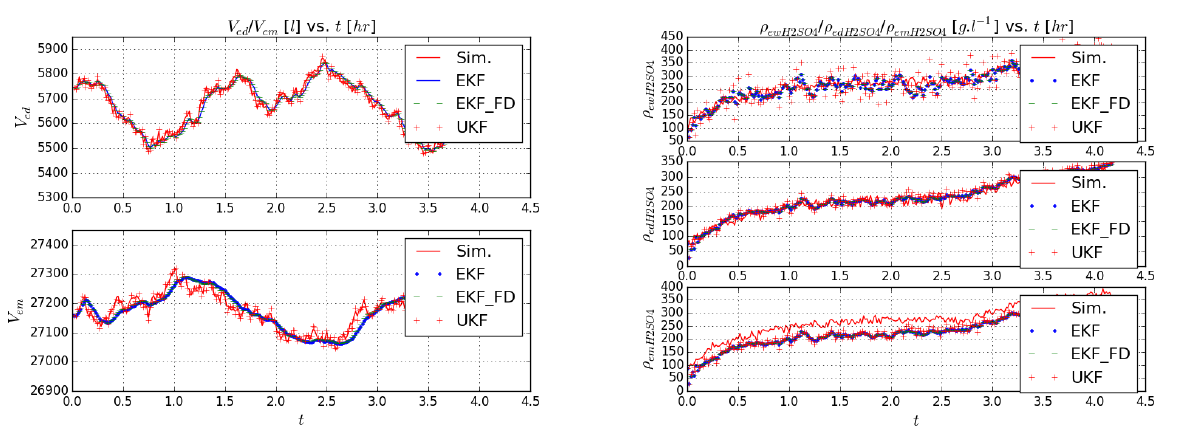
, ρ ed, H and 2 SO 4 2 SO 4